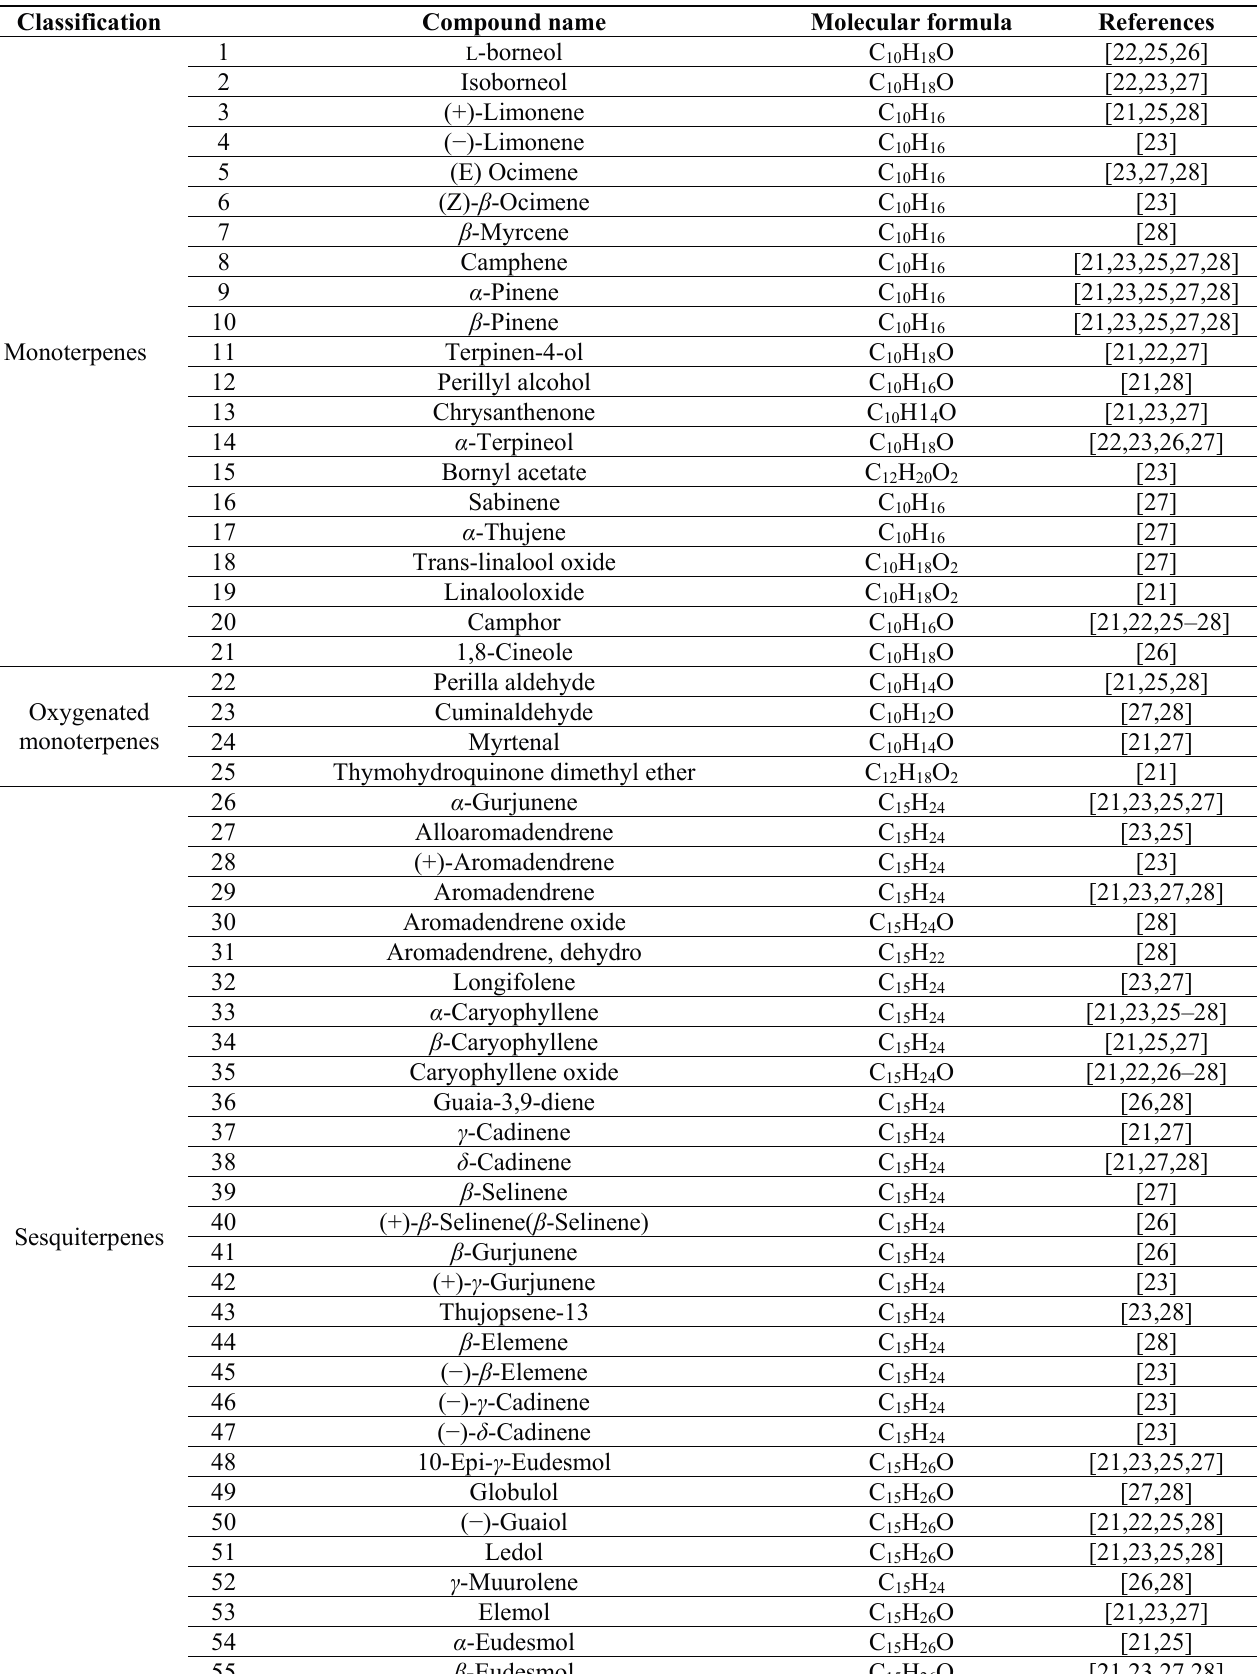
Table 1. The known volatile constituents of B. balsamifera